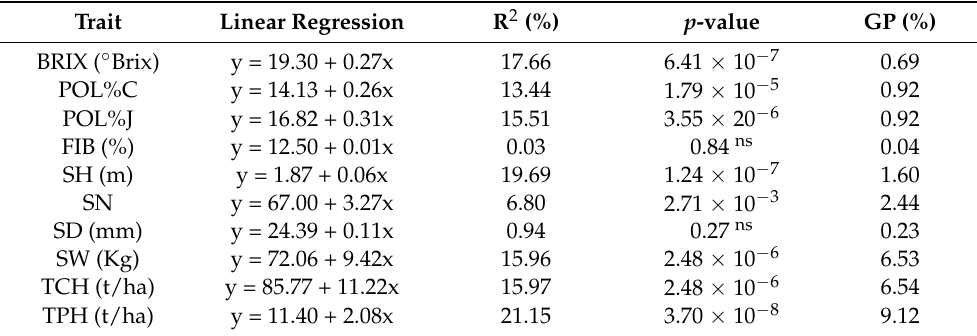
Table 2. Linear regression, coefficient of determination (R 2 ), and p -value for the angular coefficient significance and genetic progress (GP (%)) for BRIX (in ◦ Brix), sucrose content of the cane (POL%C, in %), sucrose content of the juice (POL%J, in %), fiber content (FIB, in %), stalk height (SH, in m), stalk number (SN), stalk diameter (SD, in mm), stalk weight of the plot (SW, in kg), cane yield (TCH, in t/ha), and sucrose yield (TPH, in t/ha) for accessions from Brazilian breeding programs considering six decades of